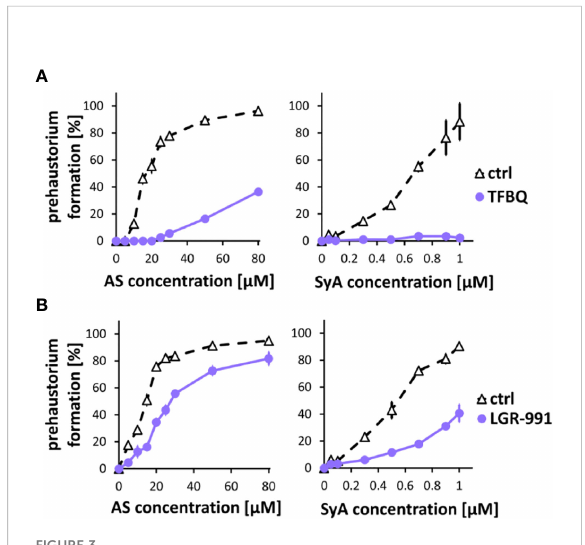
FIGURE 3 TFBQ and LGR-991 inhibit prehaustorium formation induced by phenolic compounds. S. hermonthica seedlings were treated with AS or SyA with indicated concentrations in the absence (ctrl) or presence of a quinone inhibitor TFBQ (A) and cytokinin receptor inhibitor LGR-991 (B) . 20 µM of TFBQ and 10 µM LGR- 991 were used. Data represents mean ± SE with three